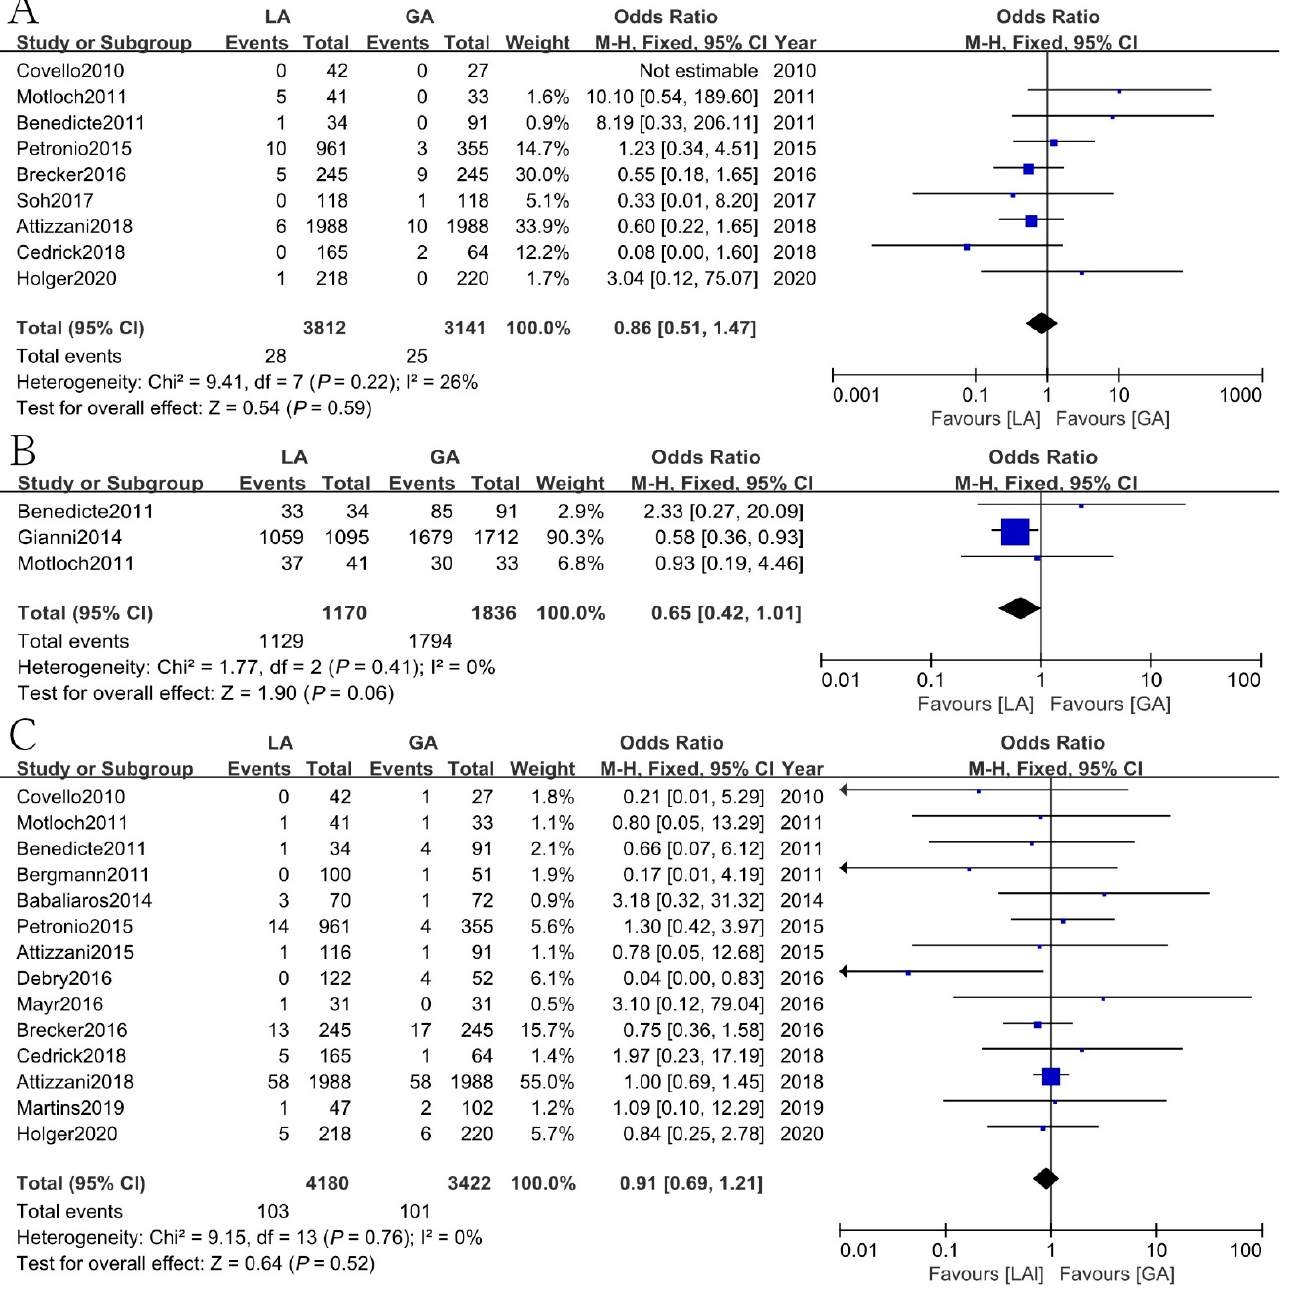
Figure 6. Forest plots of ( A ) myocardial infarction. ( B ) The rate of procedural success. ( C ) The rate of cerebrovascular events. Green symbols: continuous data; blue symbols: dichotomous data; black symbols: other type data.